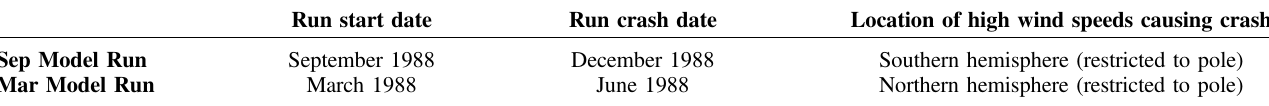
Table 1. A summary showing the model runs performed for the investigation, with its corresponding crash date and location.